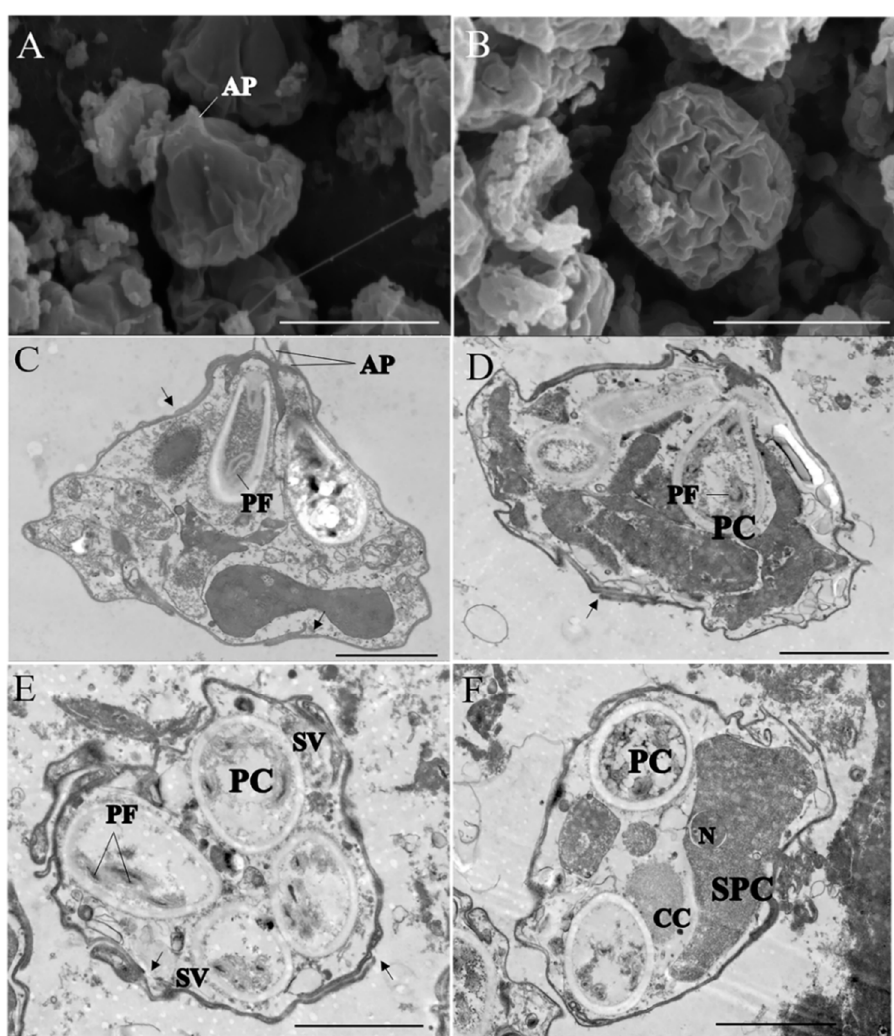
Figure 5. Electron microscopy of Kudoa . ( A , B ) SEM of K. iwatai spores. ( A ) Lateral view of K. iwatai by scanning electron microscopy. ( B ) Apical view of K. iwatai by scanning electron microscopy. Scale bar = 5 µm. ( C – F ) TEM of K. iwatai . ( C ) Ultrathin section of spore showing apical projection (AP), polar capsule (PC), and polar filament (PF). ( D ) Ultrathin section of spores showing details of desmosome-like valve junction at sutures. Note the extensive overlap of valves at sutures (black arrows). ( E ) Ultrathin section of spore showing four polar capsules (PCs), shell valves (SVs), and polar filament coils (PFs). ( F ) Ultrathin section of spore showing a capsulogenic cell (CC) with polar capsule and a sporoplasmic cell (SPC) with a nucleus (N). Scale bar = 2 µ